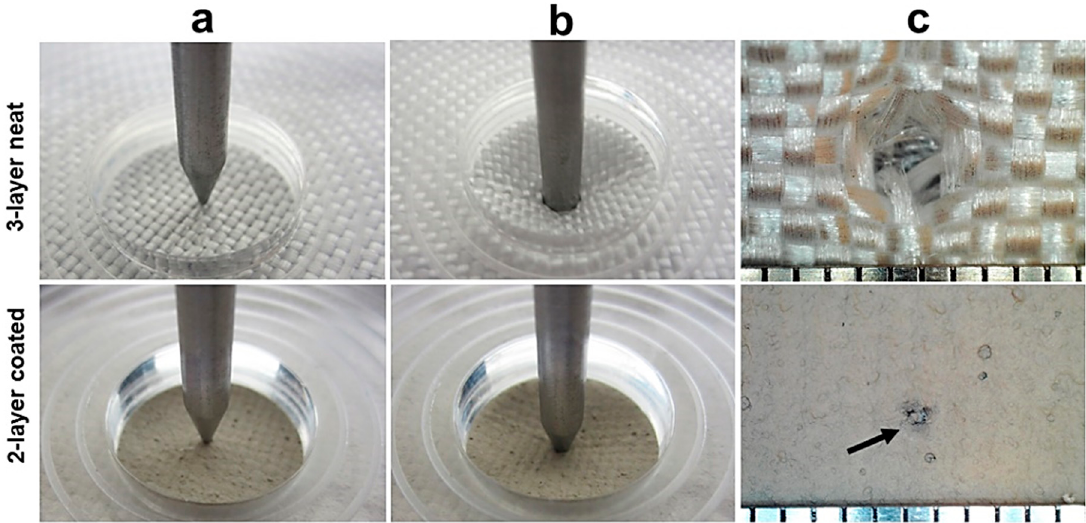
Figure 2. Images of the fabric samples undergoing the spike penetration test under a maximum pre-set load of 100 N: ( a ) start of penetration; ( b ) end of penetration; ( c ) top close view of the impact area. The top row is a 3-layer stack of neat fabric, while the bottom row is 2-layer stack of coated fabric with 50 wt.% SiC in polyurethane (PU). The arrow shows the point of contact on the coated sample (millimeter-scale).